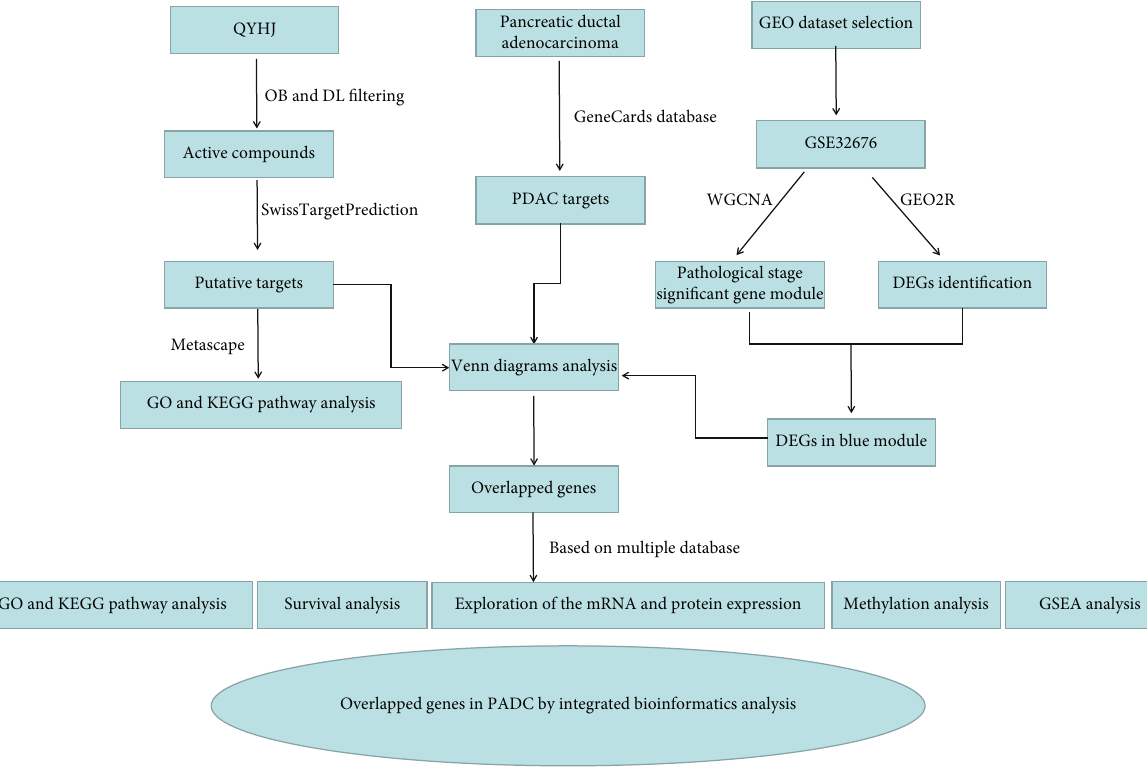
Figure 1: The fl ow diagram of network pharmacology and prognostic signatures analysis of QYHJ related targets. ADME properties of QYHJ were fi rstly assessed, and then potential therapeutic targets of QYHJ against PDAC were identi fi ed through identifying OGEs with WGCNA. Next, the GO and KEGG pathways enrichment analysis, prognostic value, expression levels, and methylation of OGEs were evaluated with multiple